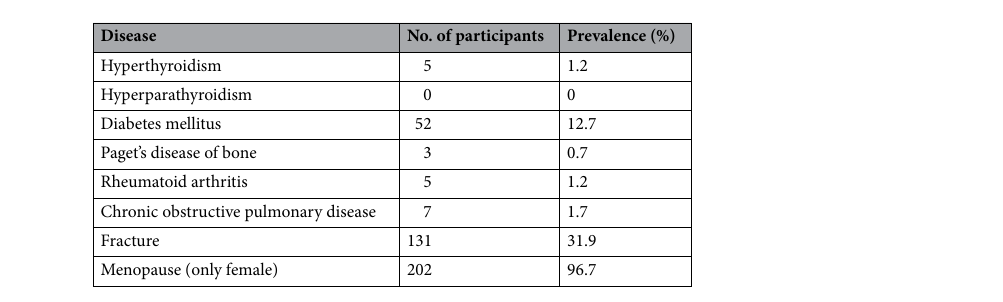
Table 2. Comorbidities in the study